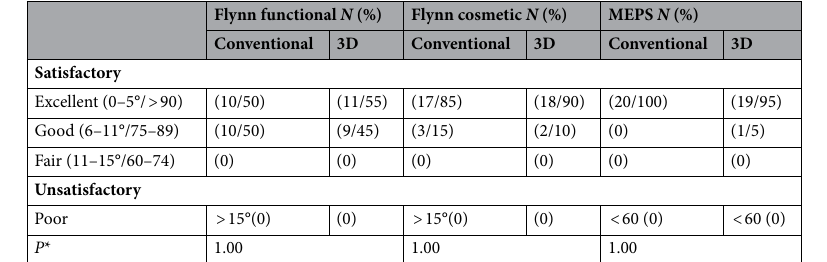
Table 2. Distribution of cases according to criteria of Flynn and MEPS in two groups. *Fisher’s exact test.